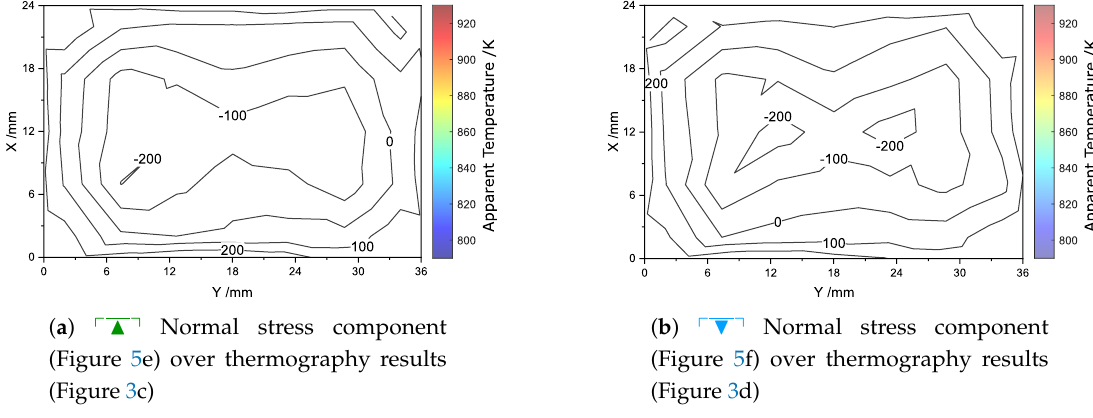
Figure 8. Normal (i.e., build direction) stress component (contour lines) in MPa (Figure 5e,f) overlayed with thermography results (Figure 3c,d) to highlight the compressive stresses at the laser’s turn locations.